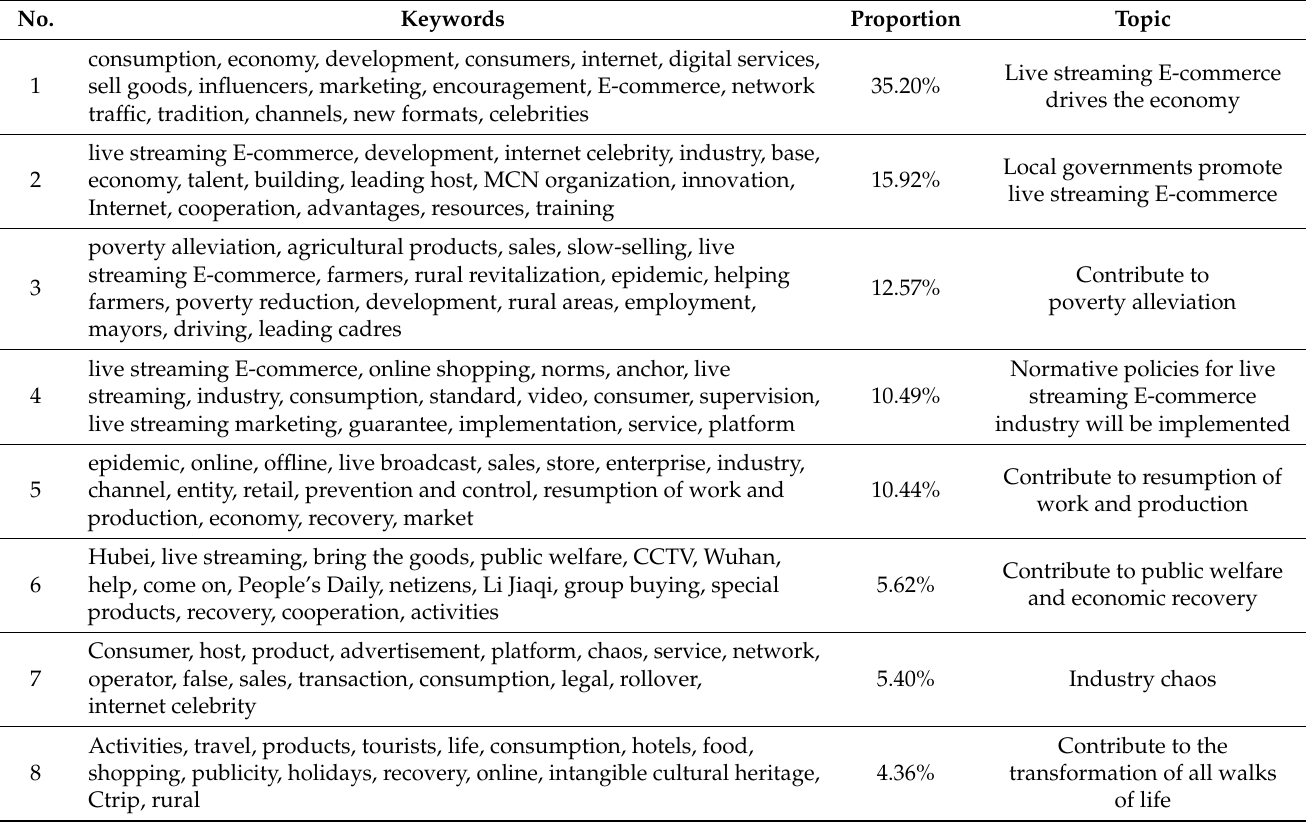
Table 3. LDA models before policy implementation.